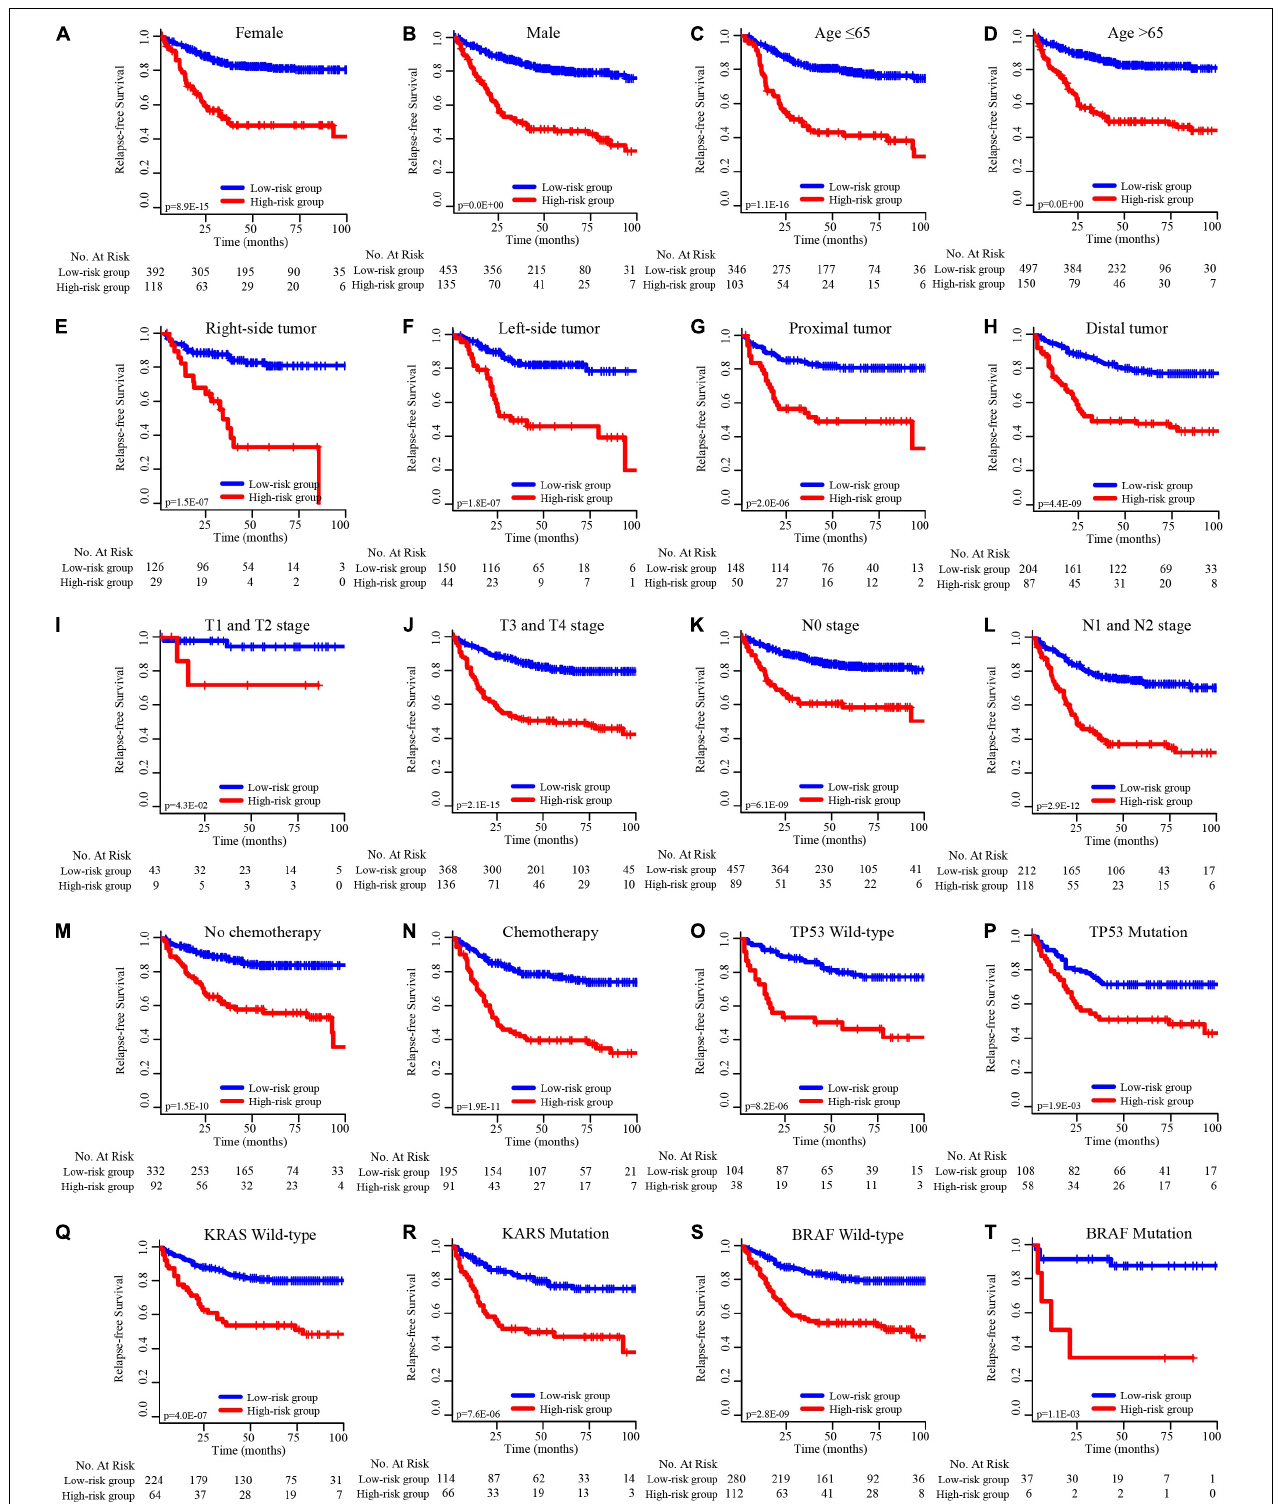
FIGURE 4 | K–M survival subgroup analysis of all CRC patients according to the EMT-related gene signature stratified by clinical characteristics. (A) Female, (B) male, (C) age ≤ 65 years, (D) age > 65 years, (E) right-side tumor, (F) left-side tumor, (G) proximal tumor, (H) distal tumor, (I) T1 and T2 stage, (J) T3 and T4 stage, (K) N0 stage, (L) N1 and N2 stage, (M) no chemotherapy, (N) chemotherapy, (O) TP53 wild-type, (P) TP53 mutation, (Q) KRAS wild-type, (R) KRAS mutation, (S) BRAF wild-type, (T) BRAF mutation.